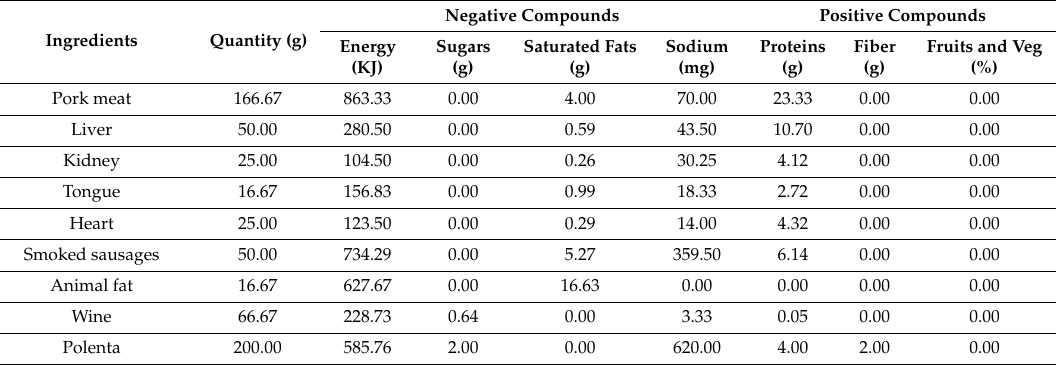
Table A3. Nutri-Score for stew of the lunch